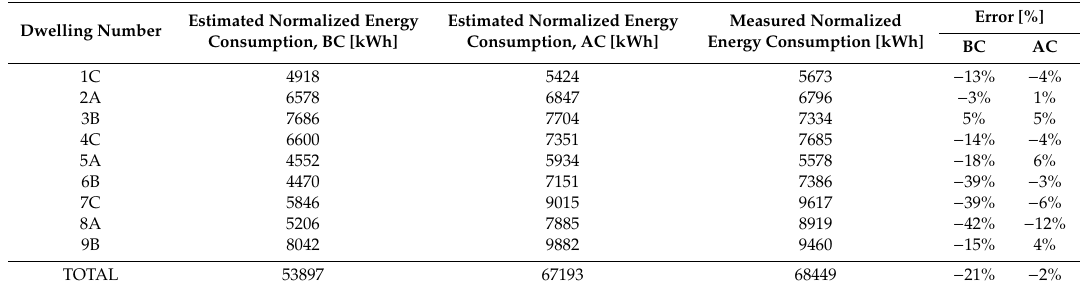
Table 3. Results of validation before and after the calibration process (respectively BC and AC). Dwelling